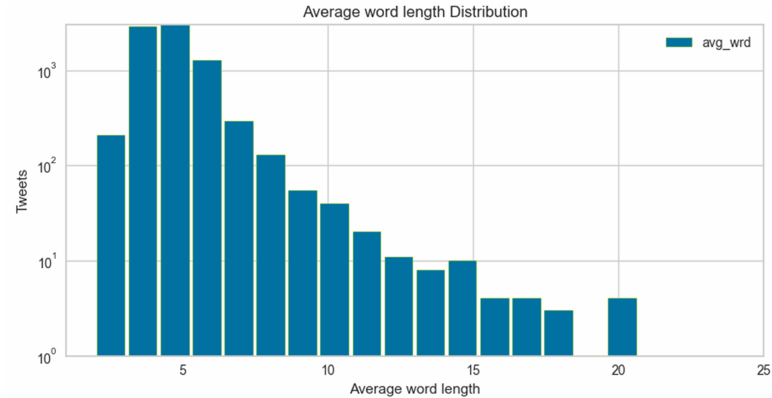
Figure 10. Average word length distribution for non-cyberbullying.